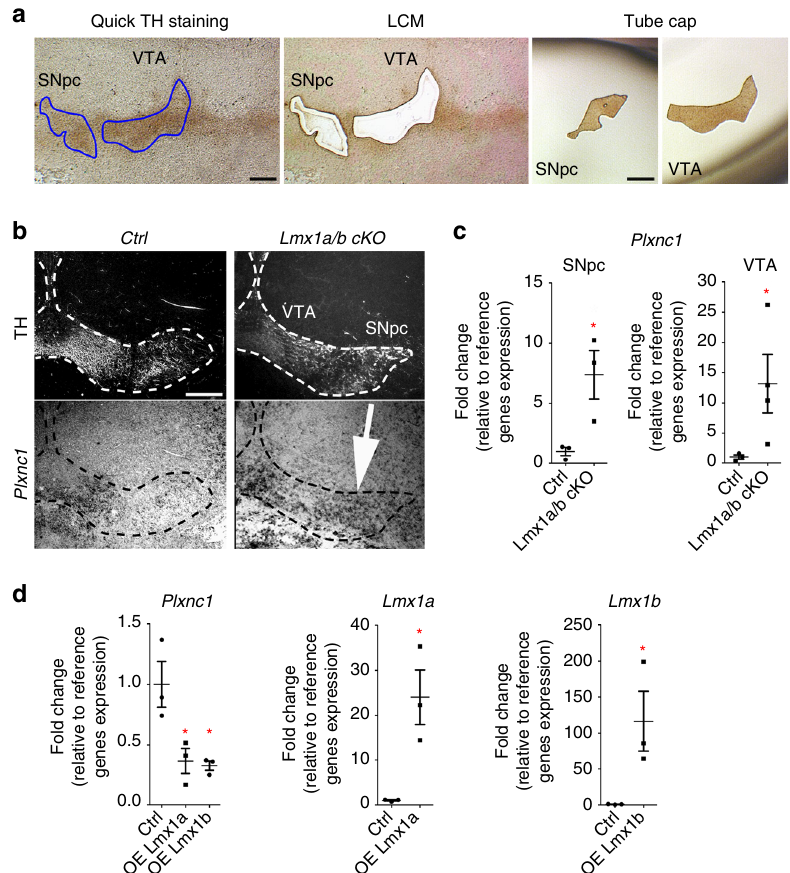
Fig. 4 Lmx1a/b regulate the expression of the axon guidance receptor Plxnc1. a Images of brain tissue section following quick TH staining, before LCM and in the tube cap after LCM. b In situ hybridization for Plxnc1 expression in ventral midbrain coronal sections of control and Lmx1a/b cKO mice at P1. c RT-qPCR analysis of Plxnc1 expression speci fi cally in SNpc and VTA neurons isolated with LCM (SNpc: n = 3, two-tailed unpaired t test, p = 0.0353; VTA: n = 3 controls and 4 Lmx1a/b cKO, one-tailed Mann – Whitney U , p = 0.0286). d RT-qPCR quanti fi cation of Plxnc1 expression after Lmx1a and Lmx1b overexpression in ventral midbrain primary cell cultures at P1 ( n = 3 independent cultures; for Plxnc1 : one-way ANOVA with Tukey ’ s post test, * p < 0.05; for Lmx1a and Lmx1b : one-tailed Mann – Whitney U , p = 0.05). Scale bars: 200 µ m (Fig. 2l). These data are consistent with a lack of DA innervation (Fig. 3g – n). When injected in control animals, back fi lled neurons in the dorsal striatum observed in Lmx1a/b cKO mice. Inversely, were observed predominantly in the VTA (Fig. 3j – l). In contrast, we found an increase in the frequency of excitatory and inhibitory injection of AAV-Retro-GFP in the ventral striatum of Lmx1a/b synaptic inputs in the ventral striatum of Lmx1a/b cKO mice cKO mice resulted in numerous labeled neurons not only in the (Fig. 2m). To con fi rm a potential axon-targeting defect, we VTA but also in the SNpc (Fig. 3m, n). Accordingly, we observed examined speci fi c axon projections of DA neurons from the SNpc the same result using the retrograde tracer Fluorogold (Supple- and VTA. We performed both anterograde and retrograde tracing mentary Fig. 5). experiments. First, we used a Cre recombinase-dependent viral vector expressing green fl uorescent protein (GFP) for labeling mDA neurons and their axonal projections 22, 23 . Ten days after birth, Lmx1a/b cKO and control (Dat cre/+ ) mice received stereotaxic injections (Fig. 3a – f). Upon Cre-mediated recombination, infected DA neurons expressed GFP. Histological analyses showed that in both the controls and Lmx1a/b cKO mice SNpc and part of the VTA neurons expressed GFP following AAV-FLEx-GFP injection (Fig. 3c, d). Analysis of GFP axons innervating the striatum corroborates with the axon-targeting defect observed with TH immunostaining in Lmx1a/b cKO mice. In control animals, GFP axons could be found in the entire striatal region, whereas in Lmx1a/b cKO mice, GFP axons were absent from the dorsal striatal region(Fig. 3e, f). We next con fi rmed this phenotype by performing stereotaxic injections of a retrograde adeno-associated viral vector (AAV-Retro-GFP 24 ) in the ventral striatum NATURE COMMUNICATIONS | 8: 933 | DOI: 10.1038/s41467-017-01042-0 |